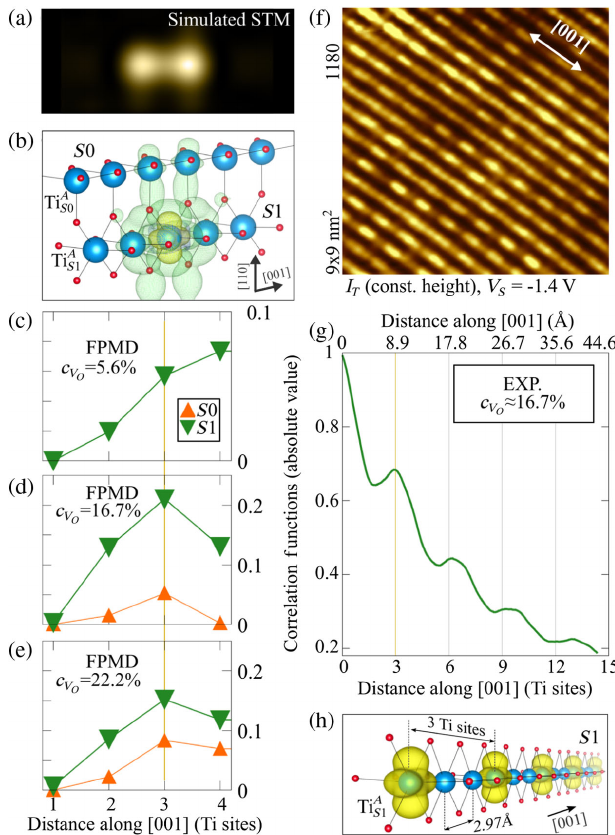
FIG. 3. Polaron distribution along the Ti A S 1 row. (a) Simulated filled-states STM (at 2 Å from the surface) of an isolated polaron around a Ti A S 1 site. (b) The corresponding charge density isosur- face shows the high-density d z 2 -like orbital localized at Ti A S 1 (yellow) and the large, low-density cloud extending across the nearby Ti A S 1 and Ti A S 0 sites. (c) – (e) Calculated polaron-polaron autocorrelation functions along Ti A S 1 and Ti A S 0 rows extracted from ¼ 5 . 6% , 16.7%, and 22.2%. (f) Experimental FPMD runs at c V O ¼ 16 . 7% , and (g) corresponding filled-states STM image at c V O polaron-polaron autocorrelation function along the [001] rows. (h) Sketch of the 3 × 1 periodicity in the Ti A S 1